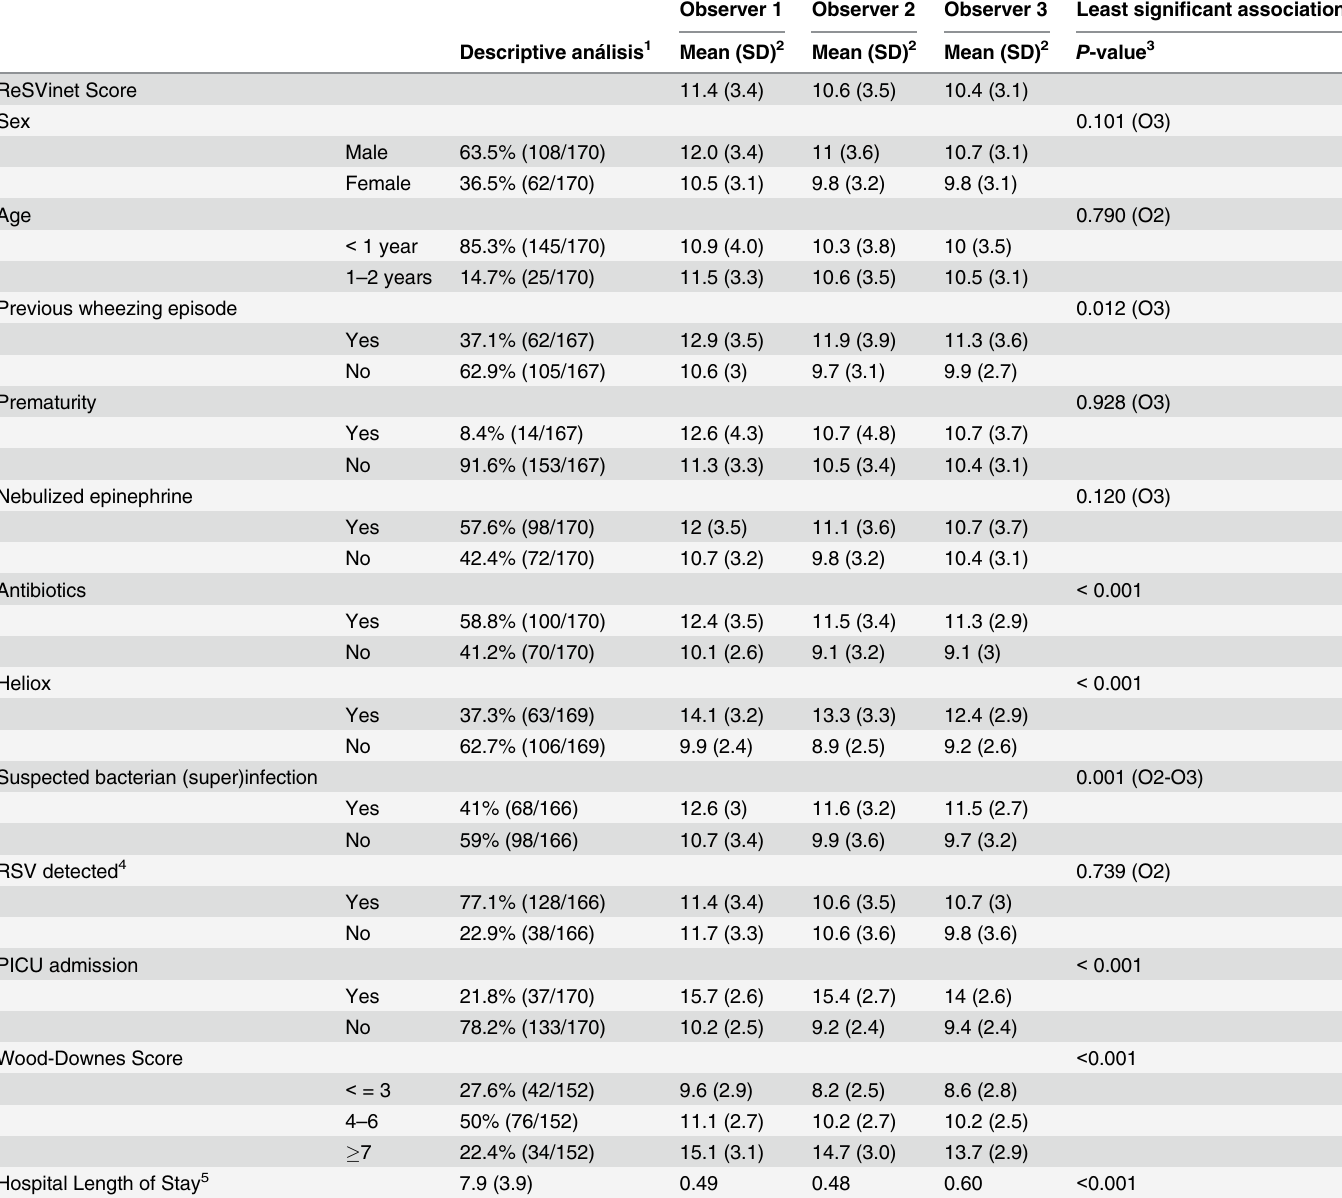
Table 3. Results of the ReSVinet scale in the professional cohort (Group 1). This table categorizes patients according to clinical, epidemiological and outcome variables in the cohort evaluated by three